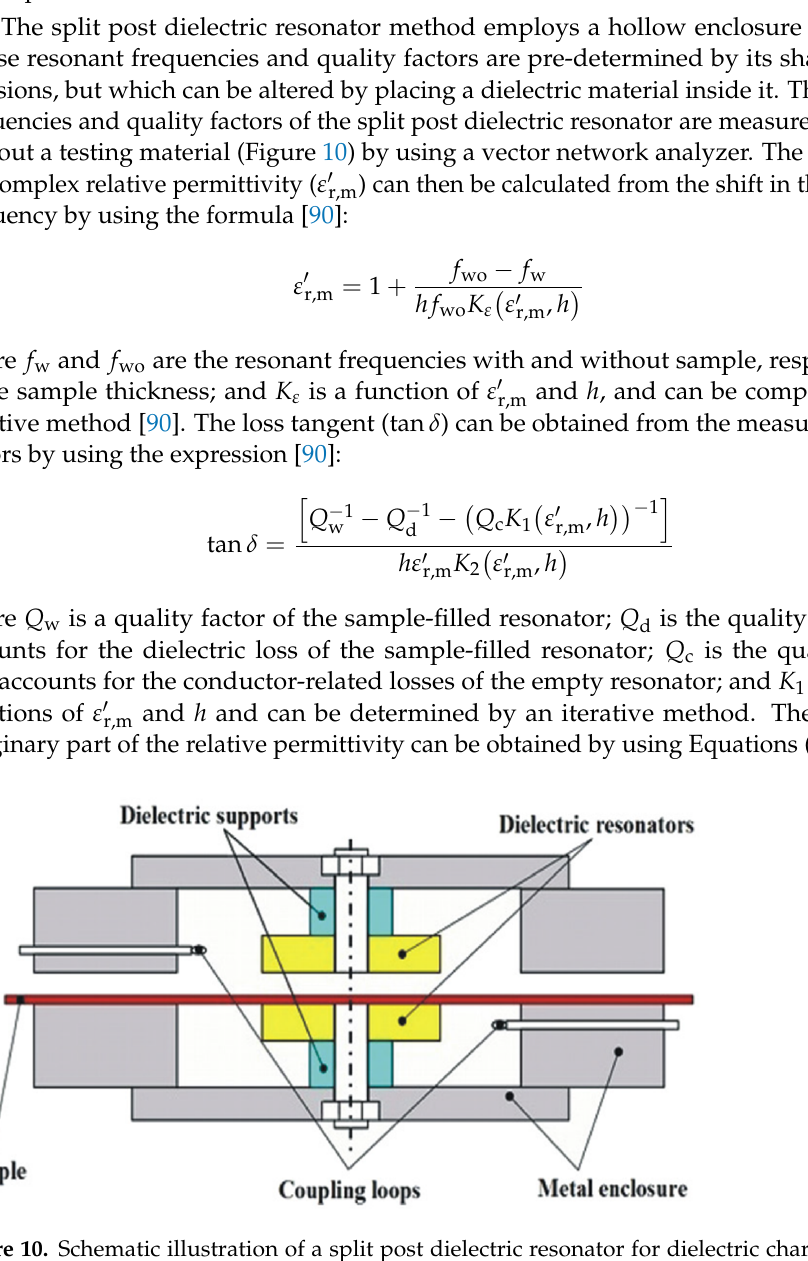
Figure 10. Schematic illustration of a split post dielectric resonator for dielectric characterization. Reprinted with permission from Ref. [91] (p. 102904). Copyright 2013 AMERICAN INSTITUTE OF PHYSICS.